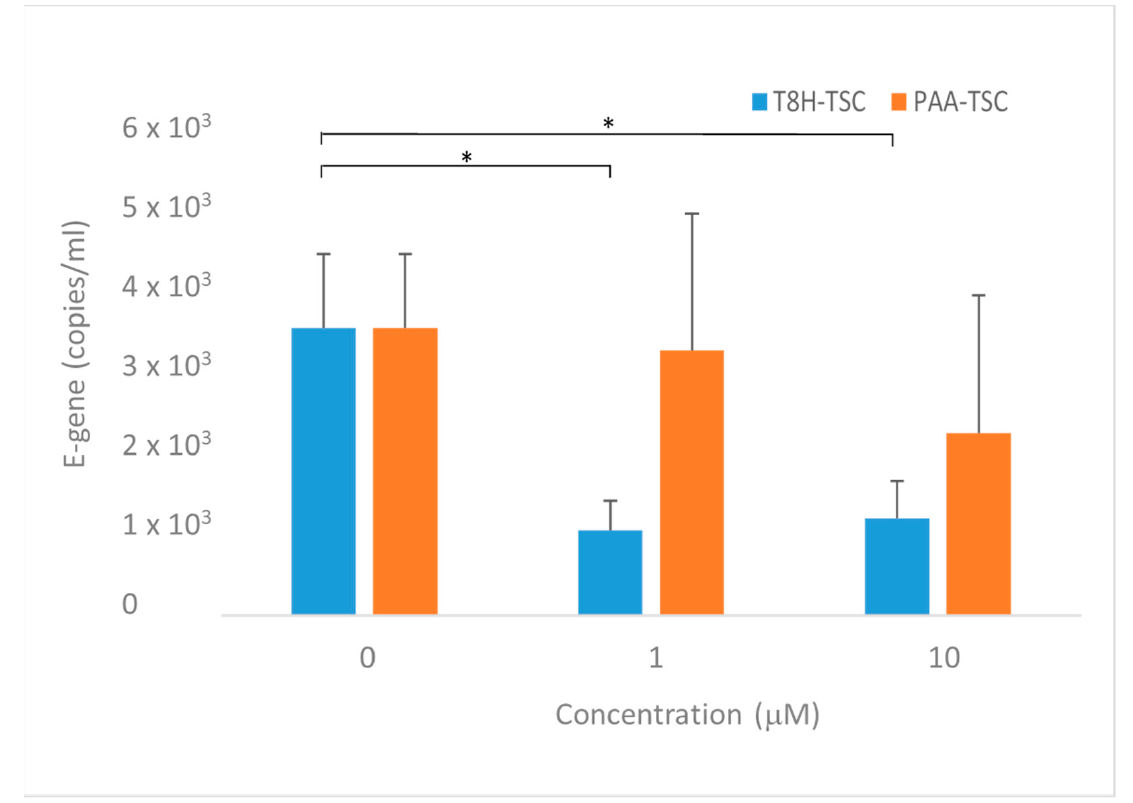
Figure 20. Effect of tested Compounds 1 (PAA-TSC) and 2 (T8H-TSC) on SARS-CoV-2 replication in Vero cells. Forty-eight hours after infection. Graphs represent mean +/ − S.E.M. Statistically signif- icant differences at * p < 0.05 (one-tailed unpaired Student’s t -test with Welch correction).